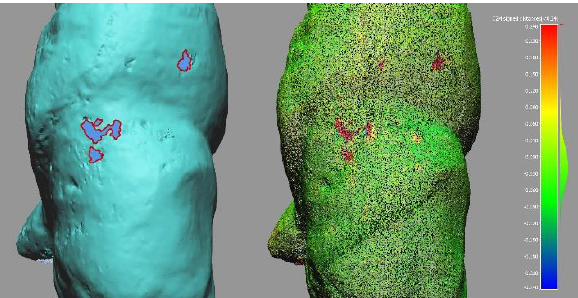
Figure 13. Mesh holes (left) and distances point-mesh (right)